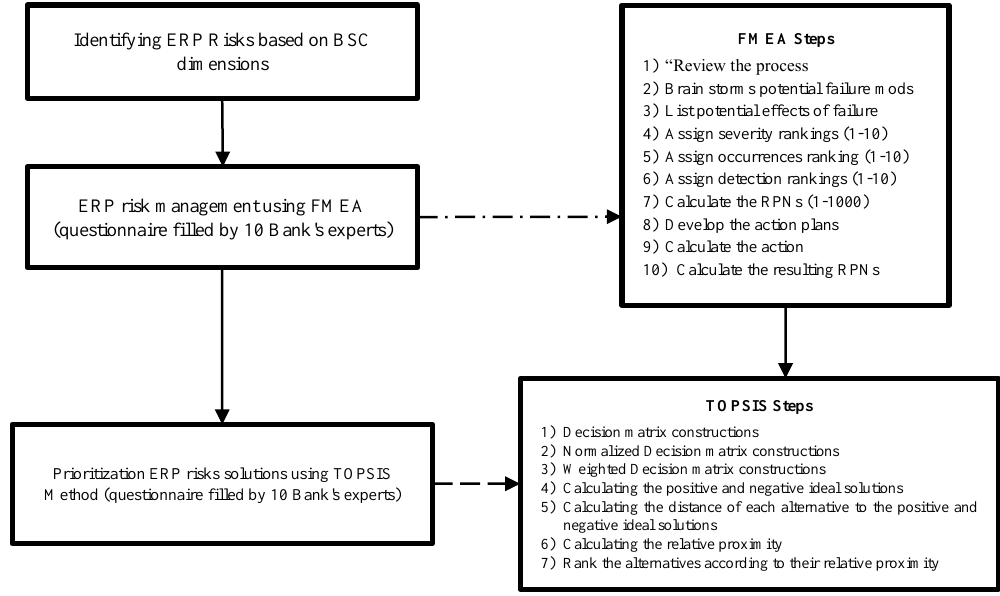
Figure 2. The research methodology